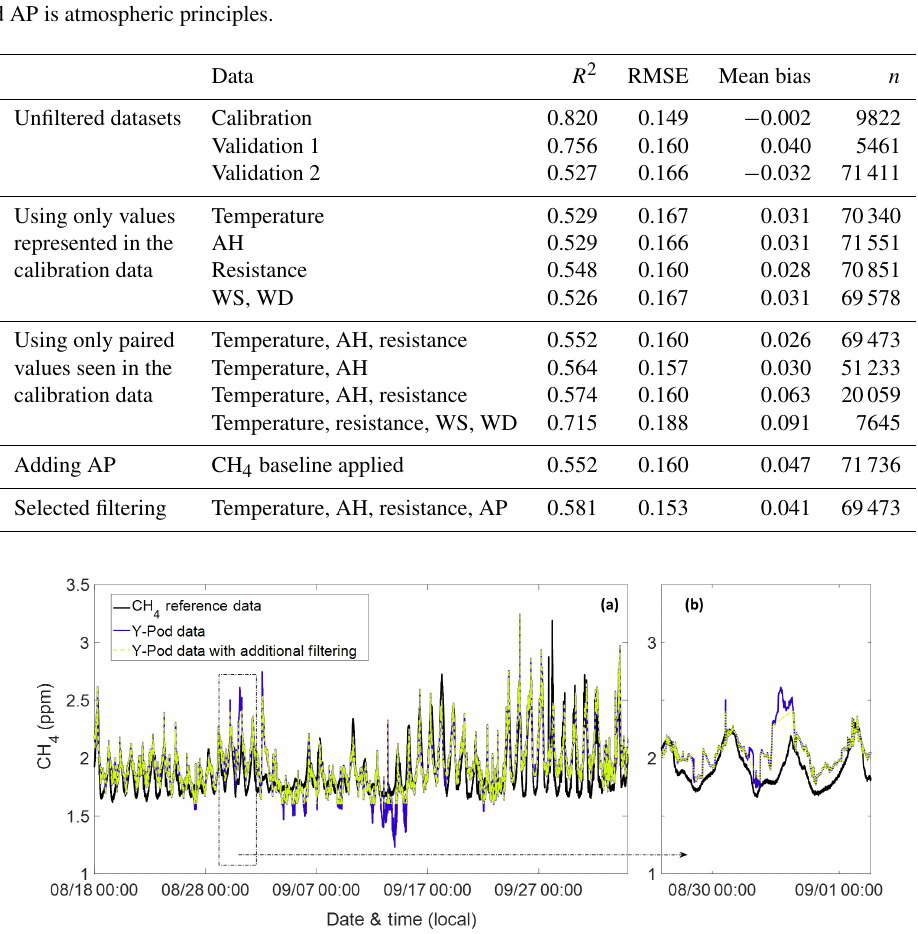
Figure 12. Panel (a) includes the complete Validation 2 dataset from the Los Angeles deployment. The statistics for each are RMSE is 0.17ppm and absolute percent relative error is 6.77% for the unfiltered data (blue); RMSE is 0.15ppm and absolute percent relative error is 6.19% for the filtered data (green), with the reference data plotted in black. Panel (b) is a close-up of approximately 2 days illustrating an instance where the filtering helped to reduce an overprediction of methane